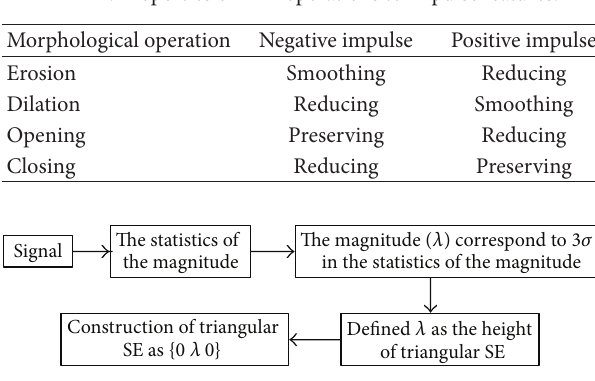
Figure 1: The construction procedure of triangular